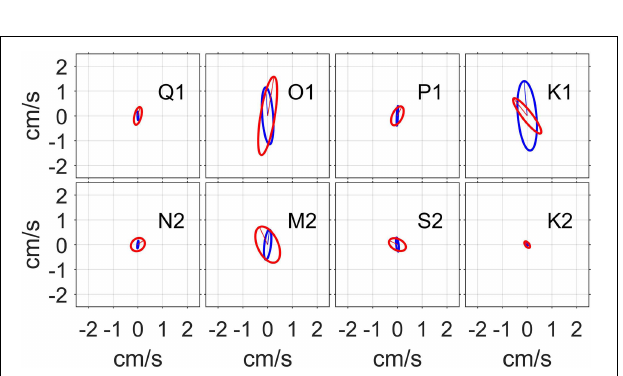
FIGURE 3 | Modal structure (A) and the vertical distribution of the square Brunt-Vaisala (B) during the observation period at the mooring station, computed by WOA18. Horizontal labels mark the start of the month.